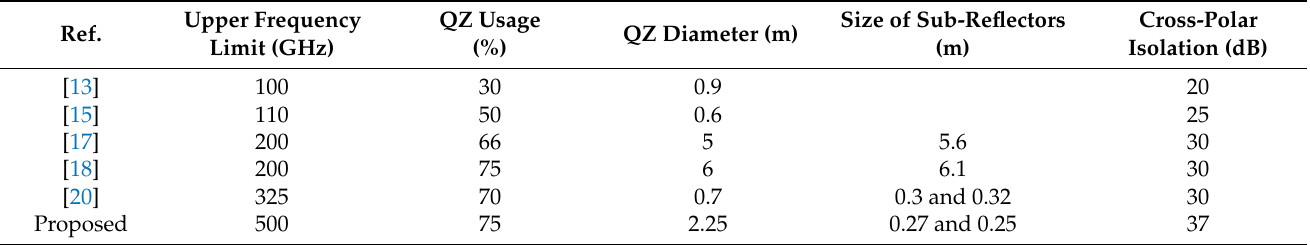
Table 3. Comparison between the reported compact antenna test range (CATR) systems and the proposed tri-reflector CATR system.